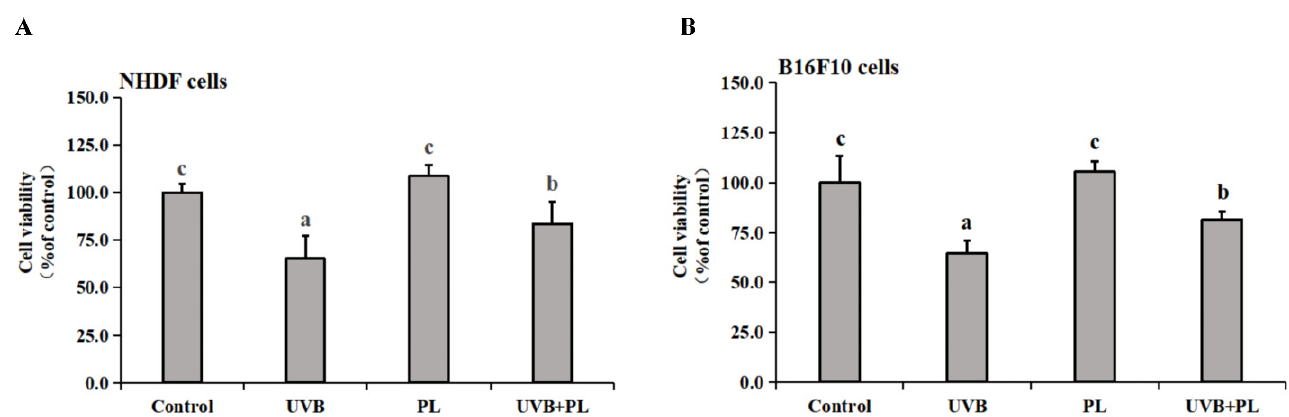
Figure 1. Effects of PL on the viability of NHDF cells ( A ) and B16F10 cells ( B ). Results were expressed as the mean ± SD ( n = 4). Differences among the variables were assessed using Duncan’s multiple range tests. Values having different letters are significantly different ( p < 0.05).